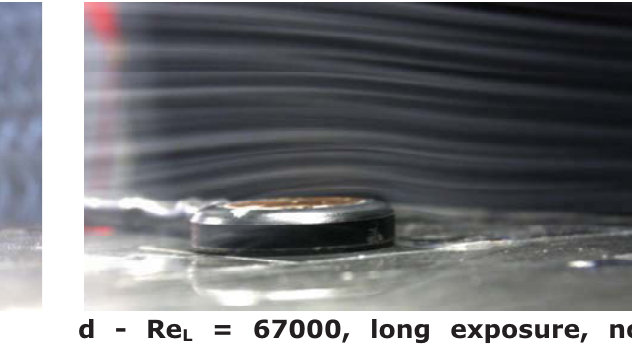
Figure 3: Flow patterns for Re